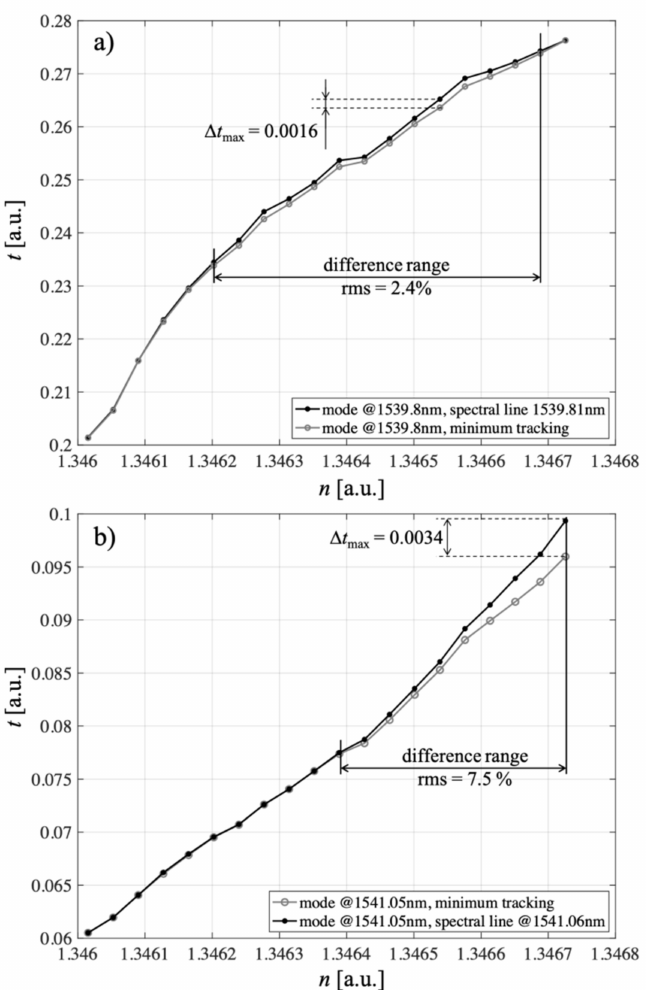
Figure 27. Processing characteristics for refractive index n measurements for two selected P-TFBG cladding modes: ( a ) @1539.8 nm, ( b ) @1541.05 nm. Measurements were performed using two methods: spectral line and minimum